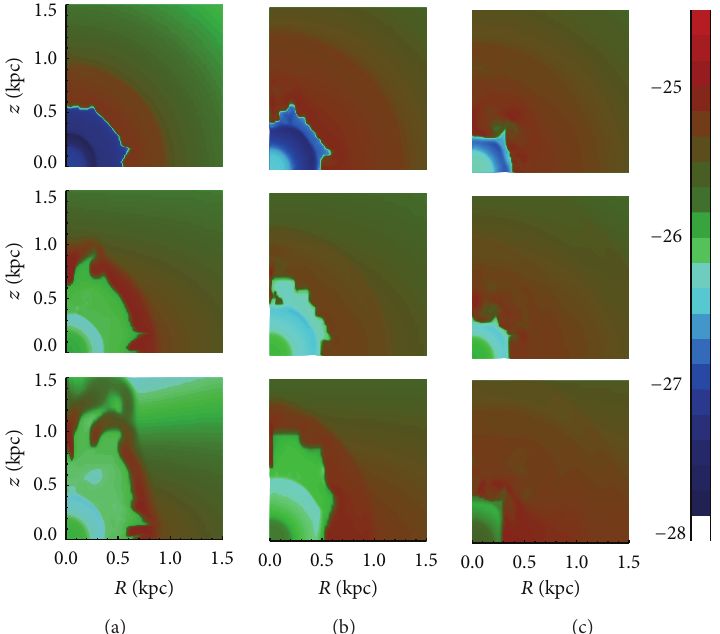
Figure 5: Gas density distribution for nine galaxy models differing on the degree of flattening and the initial baryonic mass, after 100Myr of galactic evolution. The first column represents models with 10 7 M ⨀ of initial baryonic mass, the middle column shows the gas distribution for models with mass 10 8 M ⨀ , and the right-hand column displays the models with 10 9 M ⨀ . The top rows of models are characterised by a roundish initial distribution. The middle rows show models with an intermediate degree of flattening, and the bottom rows are characterised by a flat initial distribution. The left-hand strip shows the (logarithmic) density scale (in gcm −3